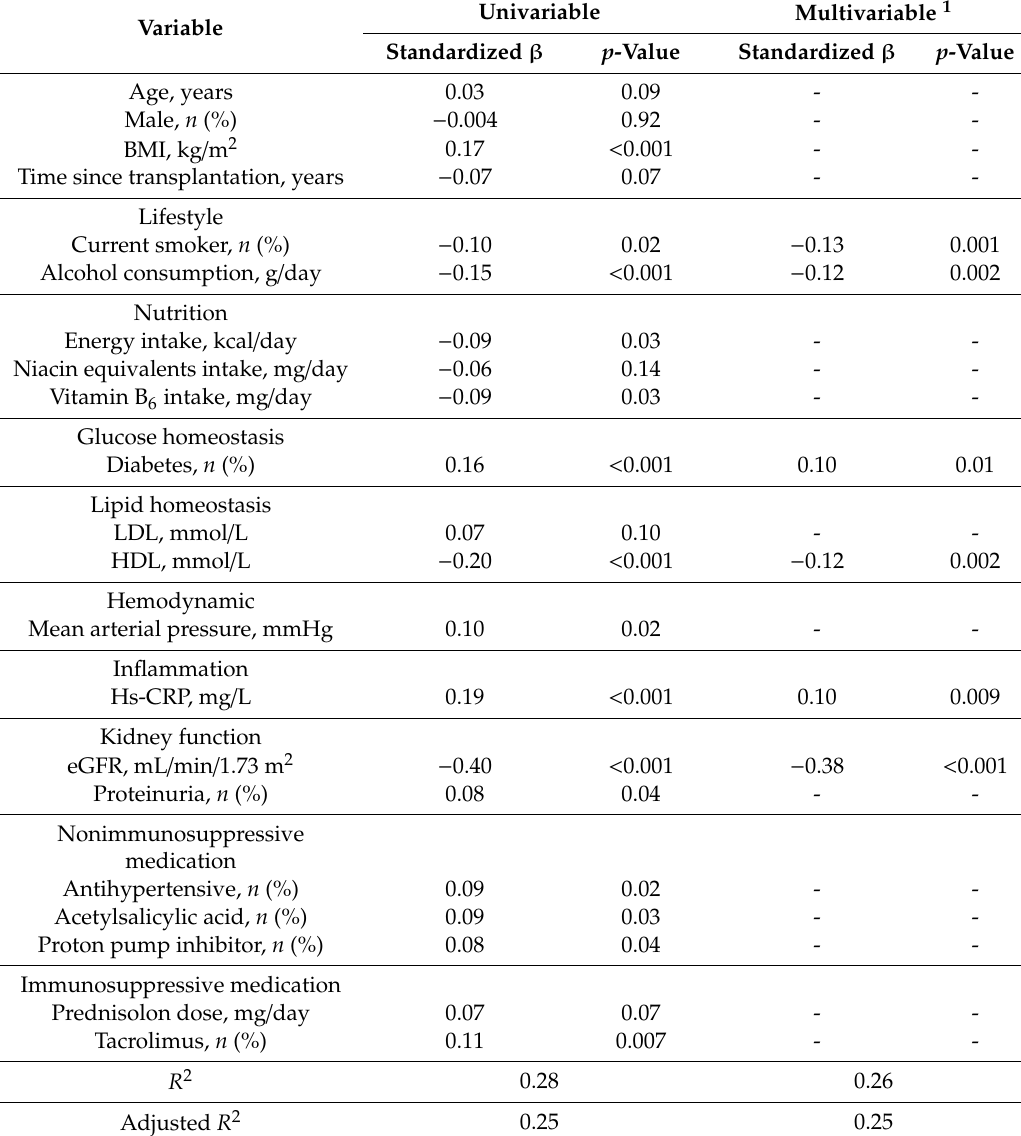
Table 4. Independent determinants of urinary 2Py / N 1 -MN in